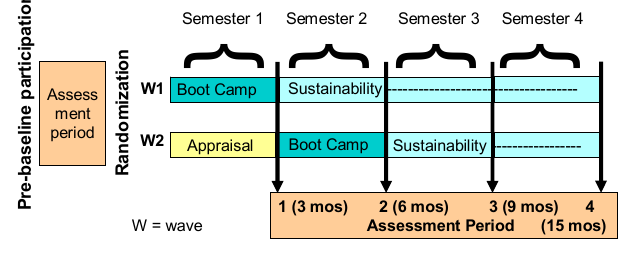
Figure 1. Study Figure 1. Study plan.